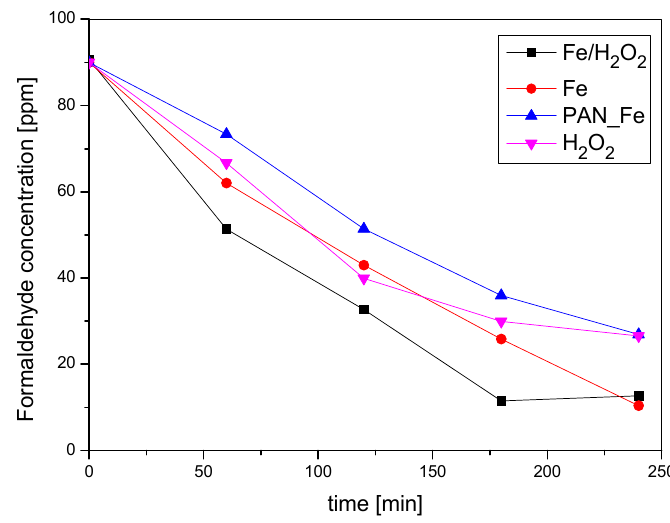
Figure 7. Formaldehyde concentration during photolysis and photo-Fenton experiment. The maximum standard deviation of the experimental points was 2.5 ppm.